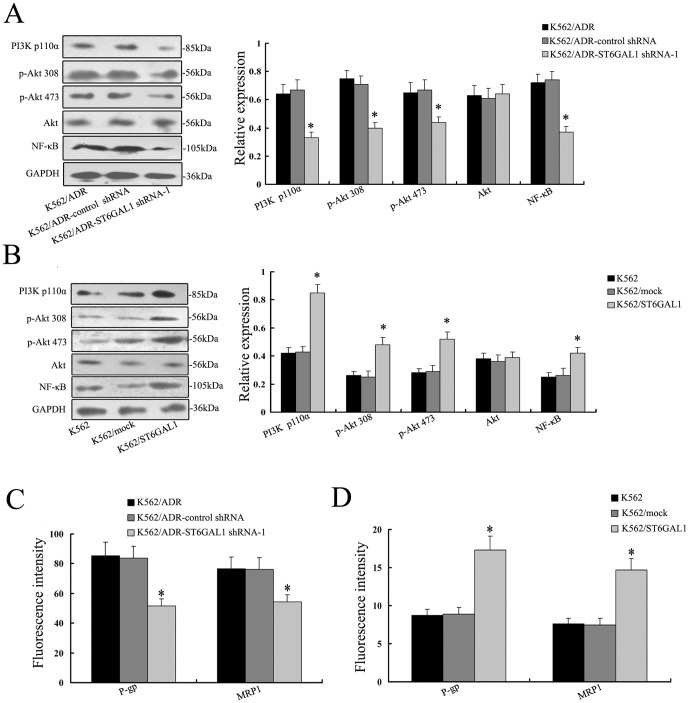
Effect of ST6GAL1-activated PI3K/Akt signaling pathway on the expression of P-gp and MRP1.(A) The main molecules of PI3K/Akt pathway were repressed at protein levels with ST6GAL1 shRNA transfection in K562/ADR cells. (B) The increased protein levels of PI3K/Akt signaling molecules were determined by western blot in K562/ST6GAL1 cells. (C) Decreased expression of P-gp and MRP1 were examined by flow cytometry analysis in K562/ADR-ST6GAL1 shRNA cells. (D) Flow cytometry analysis revealed a higher co-expression of P-gp and MRP1 in K562 cells with ST6GAL1 transfection. The data are means ± SD of 3 independent assays (*P<0.05).